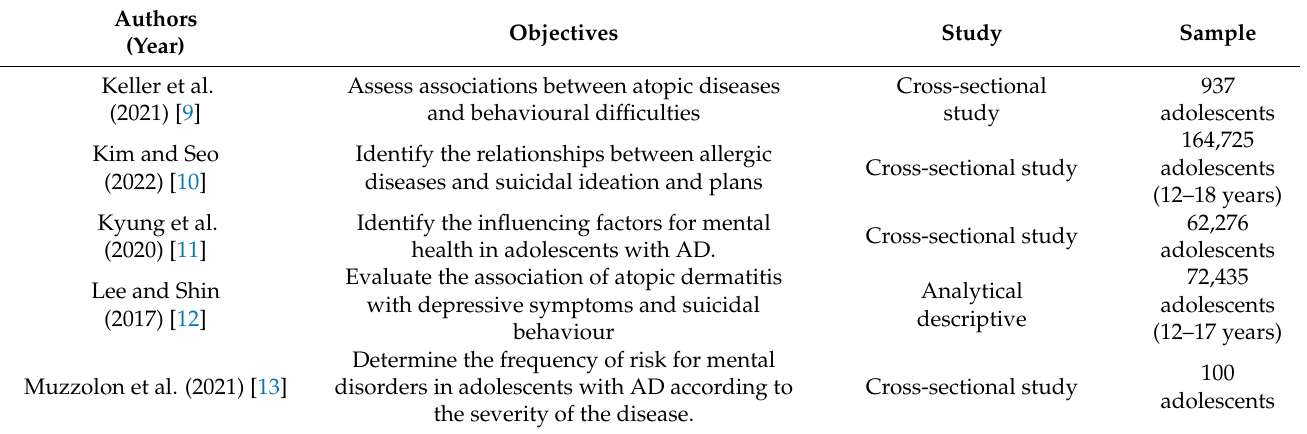
Table 1. Publications relevant to the narrative